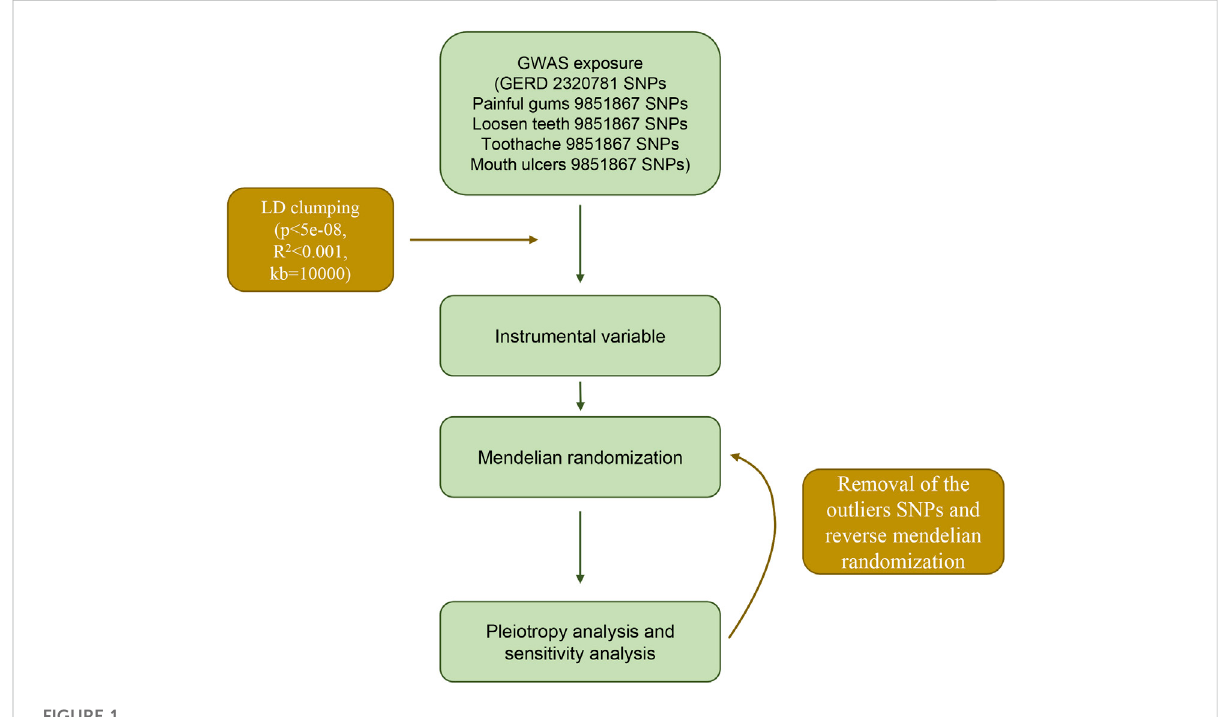
FIGURE 1 Flow chart and design of this mendelian randomization